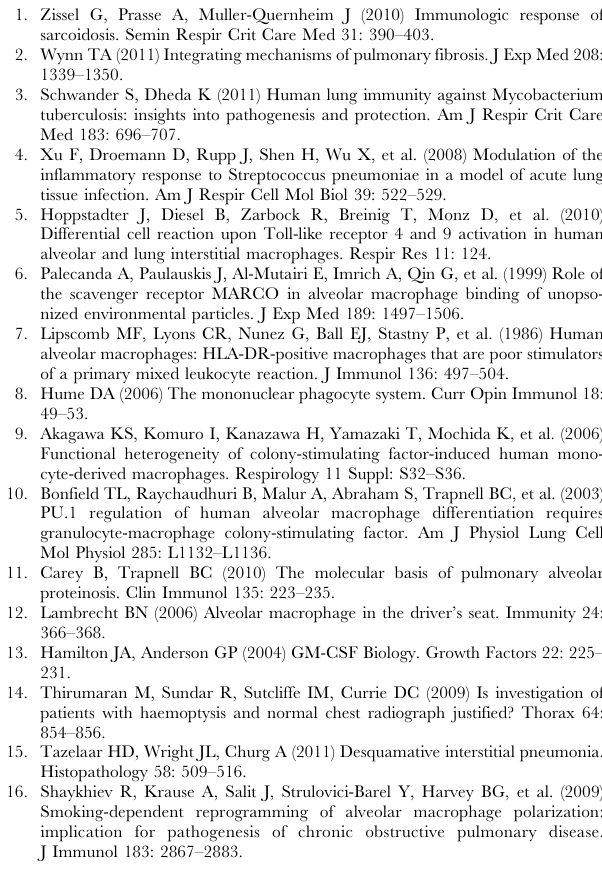
AM compared with MDM. Figure S2 Poly I:C induced pro-inflammatory gene expression in rested AM. Freshly isolated alveolar macro- phages (AM) show no pro-inflammatory transcriptional response to stimulation with poly IC (10 m g/ml), but basal levels of pro- inflammatory gene expression are reduced in AM which have been rested for 48 hours and these show significant upregulation following 4 hour stimulation with poly IC (10 m g/ml). Bars represent mean 6 SEM for 3 separate experiments (*denotes p , 0.05, t-test). Table S1 Clinical information for AM donors. Patient details for samples used for freshly isolated AM arrays * and ELISAs { , time course study of PTGS2 expression { and 48 hour rested AM 1 . DIP= desquamative interstitial pneumonia. Table S2 Supporting literature for macrophage tran- scriptional signature. In genome-wide expression data, genes that showed significantly higher expression ( . 8 fold) in monocyte derived macrophages compared to standard reference RNA were subjected to PubMed searches to identify those that are known to be expressed by macrophages, and thereby generate a transcrip-